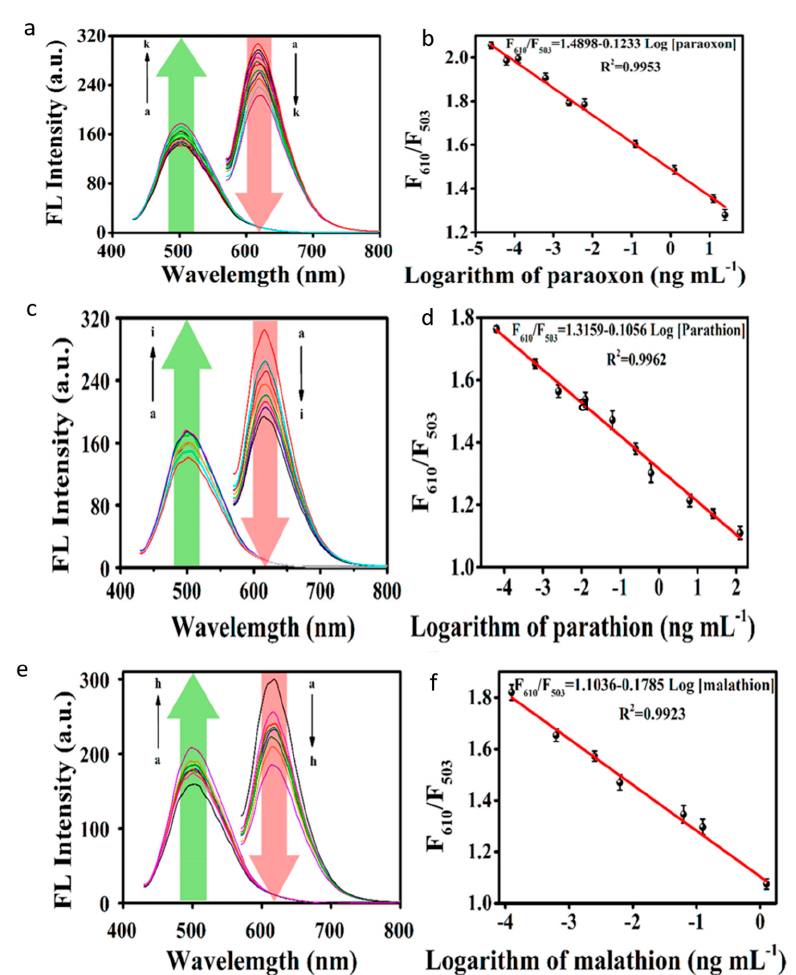
Figure 25. Increase in 503 nm fluorescence of polydopamine (PDA) and concomitant decrease in 610 nm fluorescence of C-dots with increasing concentration of ( a,b ) paraoxon, ( c,d ) parathion and ( e,f ) malathion, with corresponding standard curves allowing quantitation of OP levels. Reprinted with permission from reference [90]. Copyright (2020) American Chemical